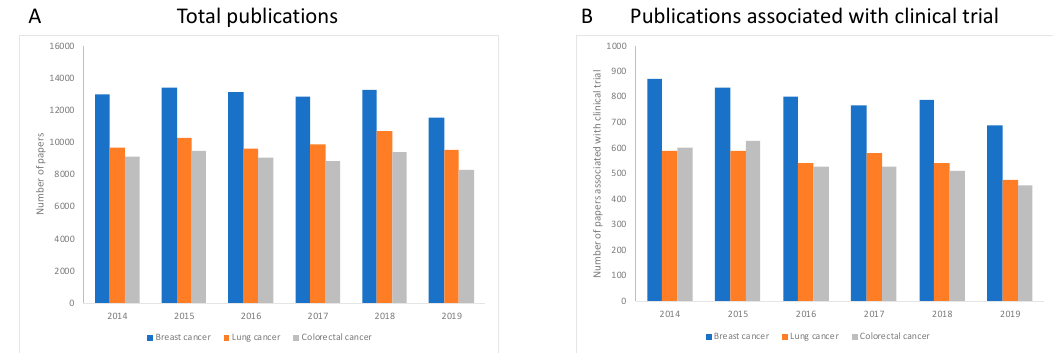
Figure 1. Publications for each type of cancer investigated, and associations with clinical trials. Panel A shows the total number of published studies retrieved from PubMed during the period 2014–2019, for each type of cancer, regardless of the technology used. For each of the three cancer types, the number of publications is reduced over time. Panel B shows that the same was true for studies associated with clinical trials, where the number of published studies associated with a clinical trial decreased for each cancer type between 2014 to 2019.